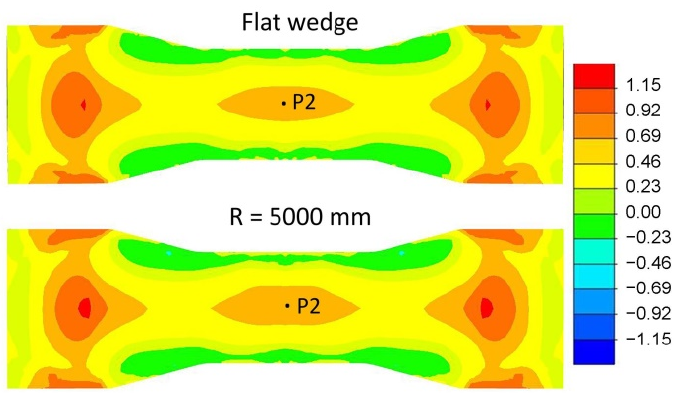
Figure 17. Distribution of the stress-state indicator values σ 1 / σ i for the least and most favourable conditions.